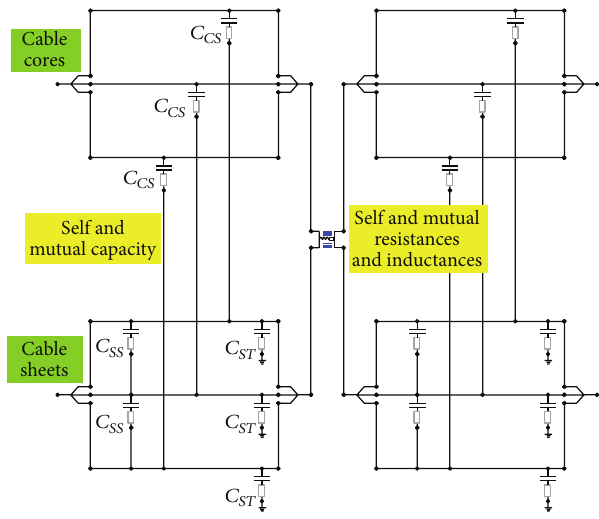
Figure 6: The final model for a section of the MV cable.